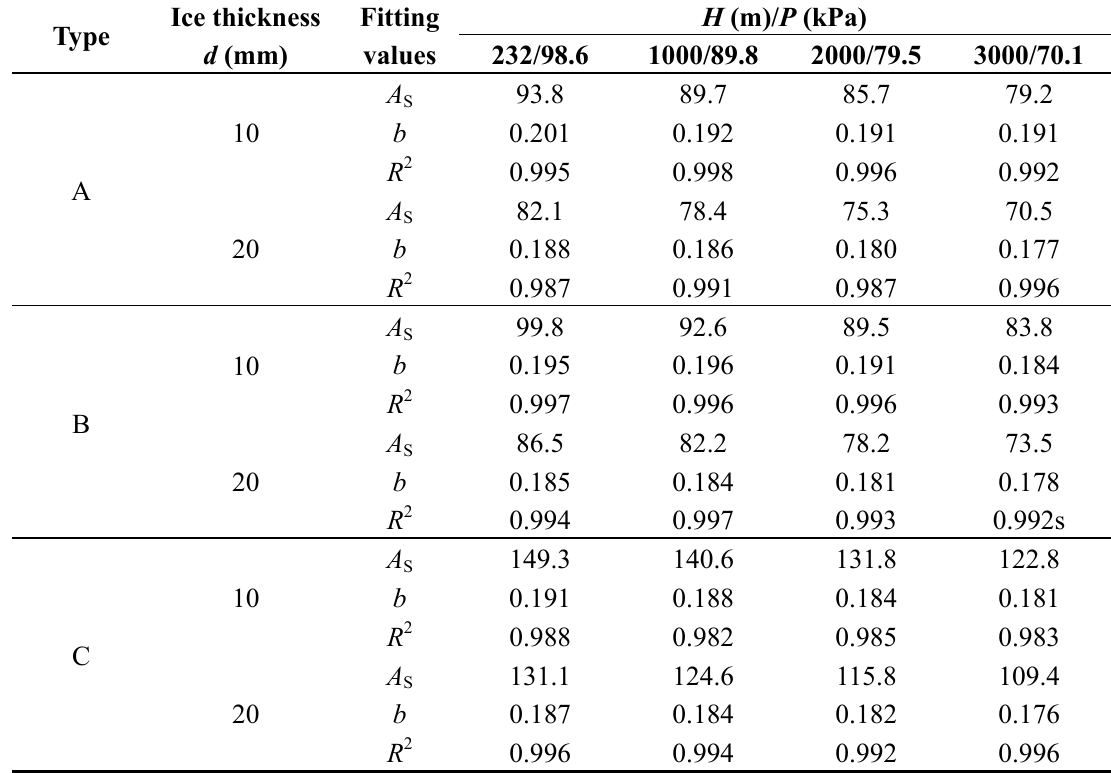
Table 6. Fitting values of A Equation